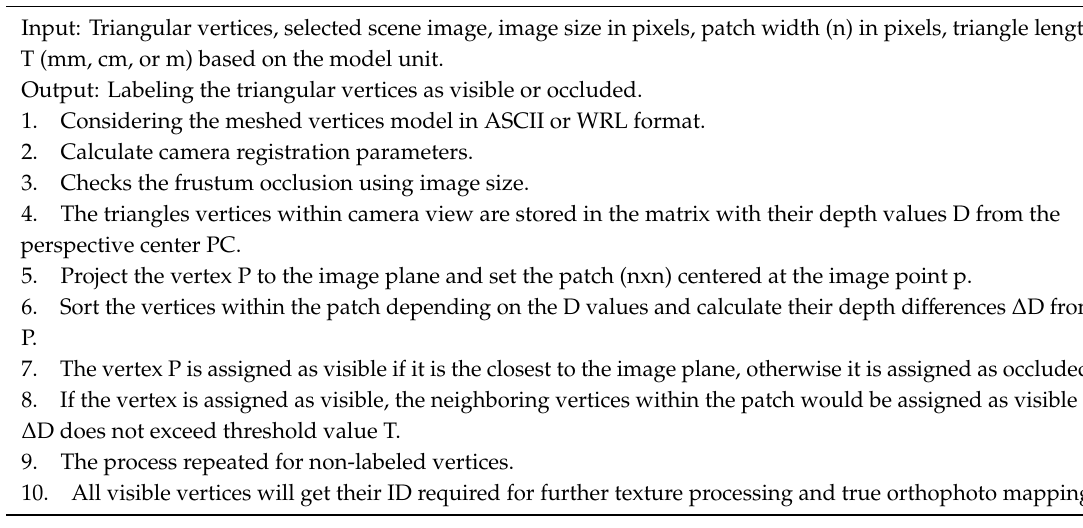
Algorithm 1 The proposed visibility analysis